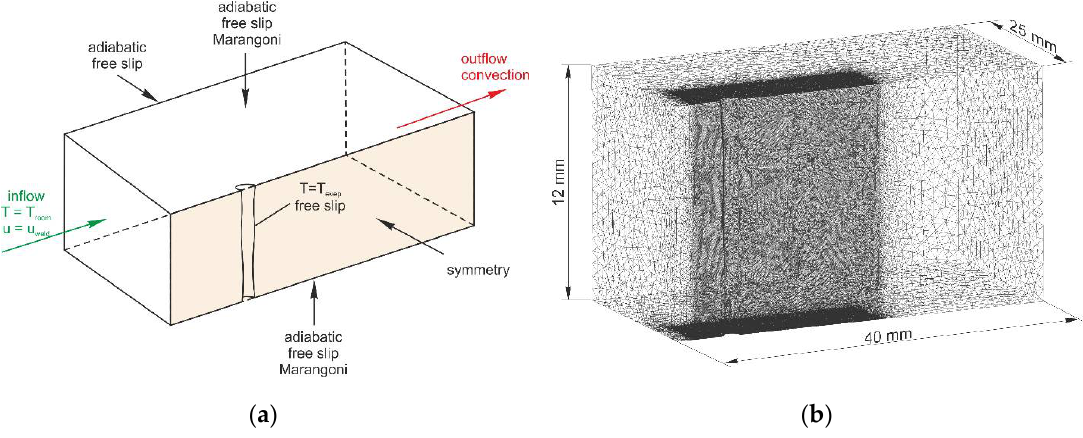
Figure 3. ( a ) Boundary condition of the computational fluid dynamic (CFD) model according to [20,21]. ( b ) The model after meshing.